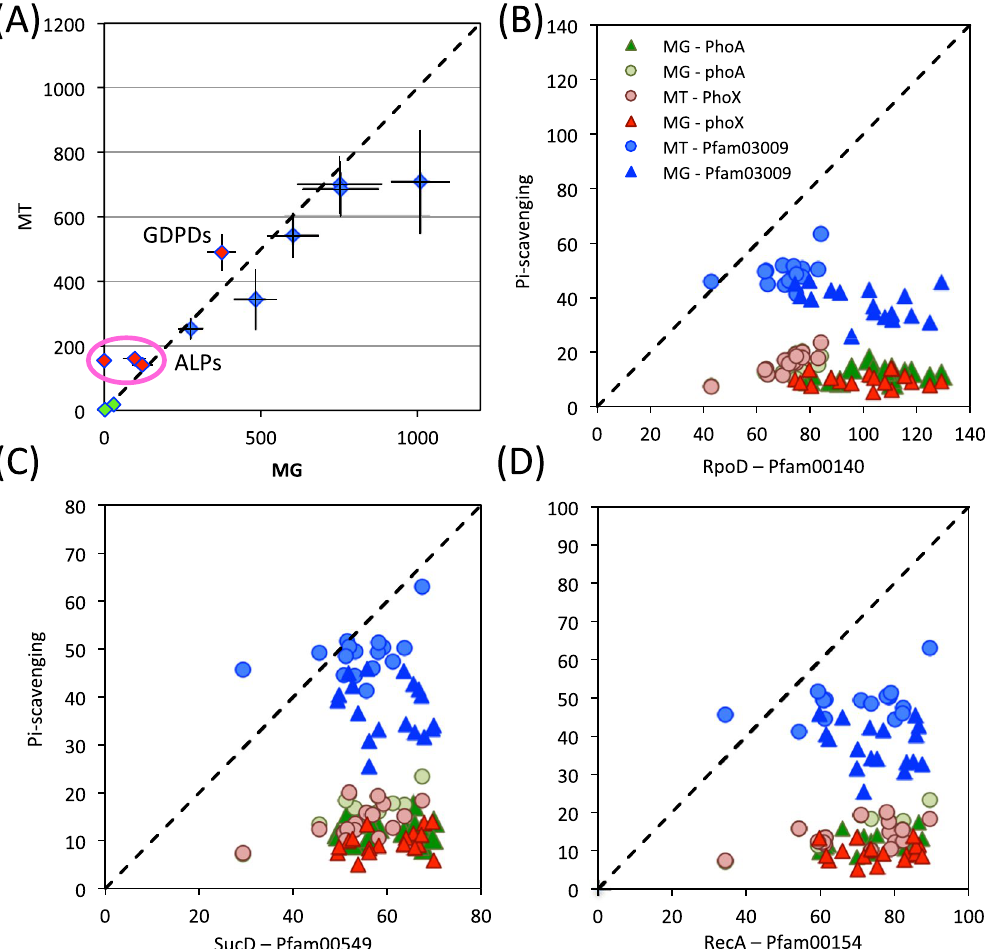
Figure 5. The abundance of various genes and their corresponding transcripts encoding Pfam domains associated with various phosphate (Pi)-scavenging (pink diamonds), nitrogen fixing (green diamonds) and housekeeping functions (blue diamonds) sampled at the Centre INRS-Institut Armand-Frappier, Laval, Canada ( A ). The mean (n = 16) number of reads assigned to each Pfam domain retrieved from either the metagenomes (MG) or metatranscriptomes (MT). Error bars denote standard deviation. The number of reads assigned to various Pfam domains associated with Pi-scavenging were plotted against the number of reads assigned to Pfam domains associated with RpoD ( B ), SucD ( C ), RecA ( D ). Abbreviations: ALPs, alkaline phosphatases; GDPDs,